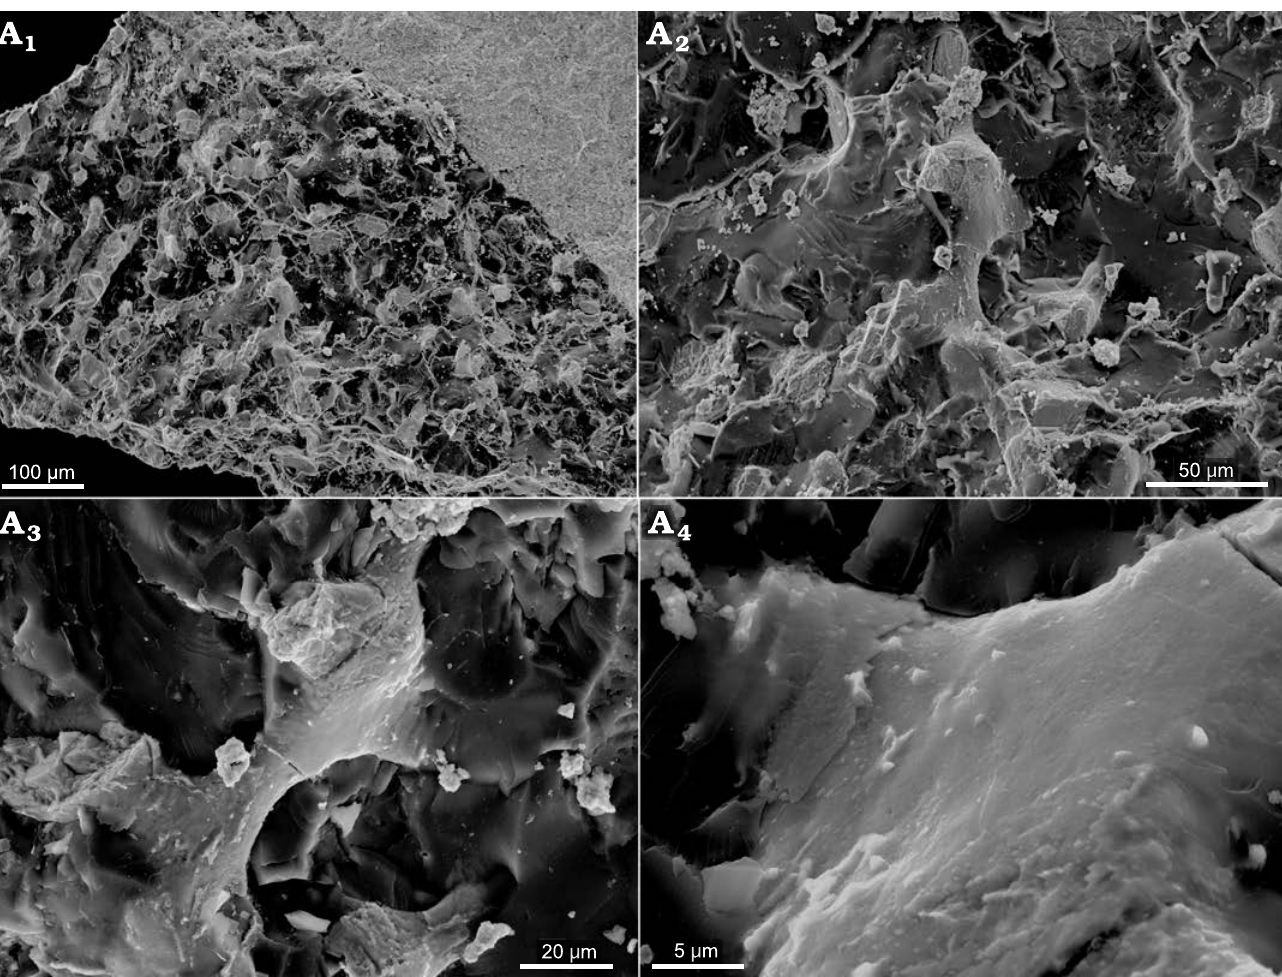
Fig. 9. A fracture of the hypothesized “beak” of the coleoid cephalopod Phragmoteuthis bisinuata (Bronn, 1859) (GBW 2006/011/0009); lower Carnian, Upper Triassic, Cave del Predil, NE Italy. A 1 , “nano-porosity” of the matrix of the hypothesized “beak”; A 2 , A 3 , bone-like structures (light grey) in the matrix (dark grey) (enlargements of Fig. 8A 1 , A 2 ); A 4 , enlarged detail of Fig. 8A 3 to show a smooth surface of dense bone-like